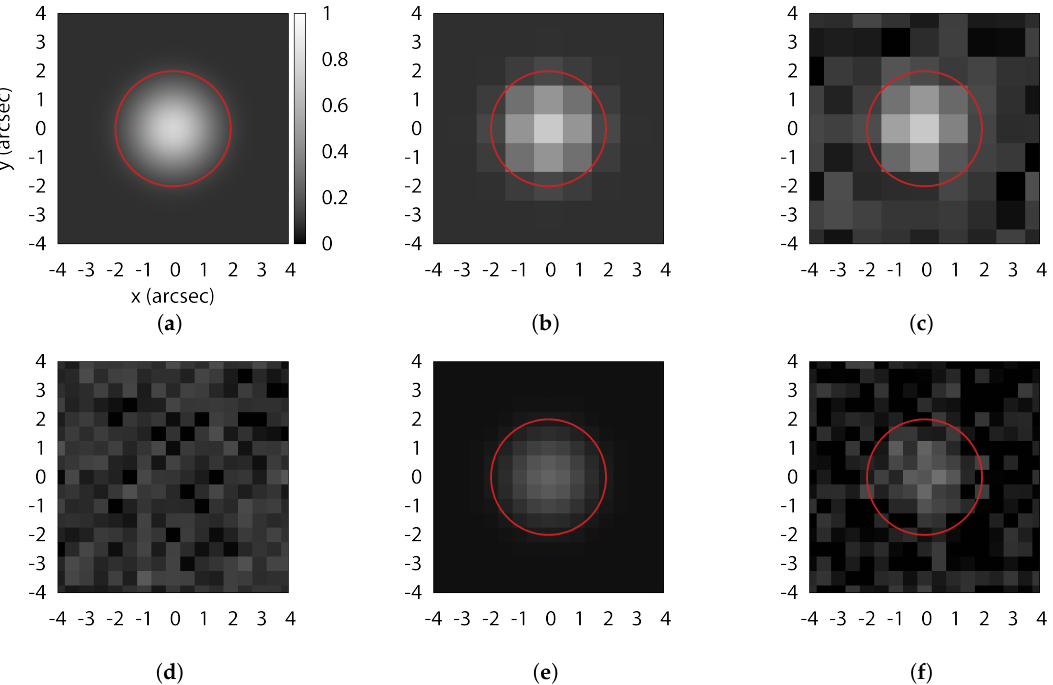
Figure 2. Effect of sampling a two-dimensional Gaussian of 2arcsec FWHM ( a ) by image scales 1arcsec/pix ( b ) and 0.5arcsec/pix ( e ) and with source Poisson and Gaussian read noise ( c , f ). Sample detector read noise is shown in ( d ). Red circles represent 2arcsec radii photometric apertures. All figures are at the same spatial and intensity